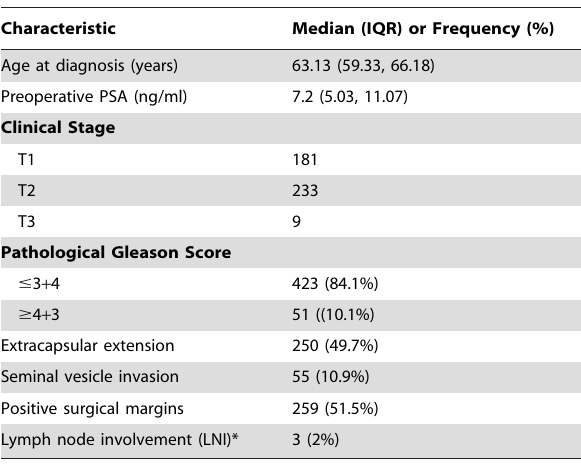
Table 1. Summary of patient characteristics